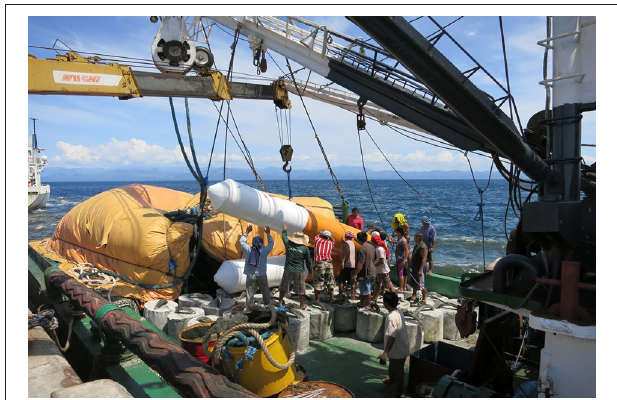
FIGURE 3 | Materials ready for deployment offshore including steel FADs. Note the rocket like steel drum. The nose always points to the direction of the current; the fishers are standing on concrete anchors made of mixed gravel, stones, rocks, and cement.